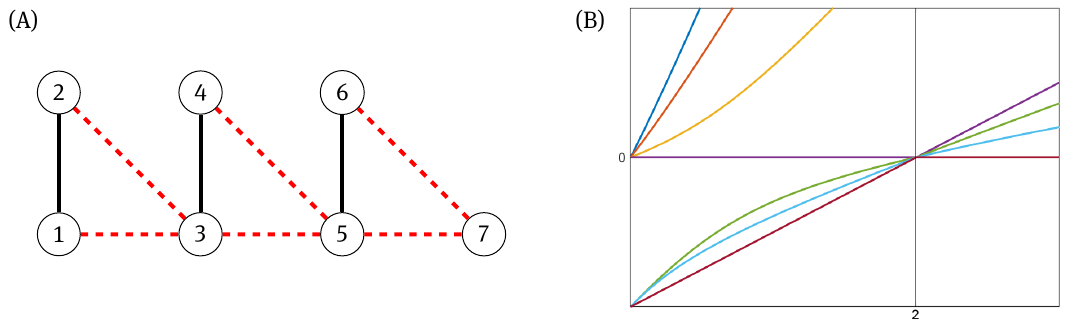
Figure 4: (A) Signed graph G · G · G where G = K 3 with one positive edge and two negative edges. (B) A 3 -crossing of a consistent weighting of G · G · G with weights ±1